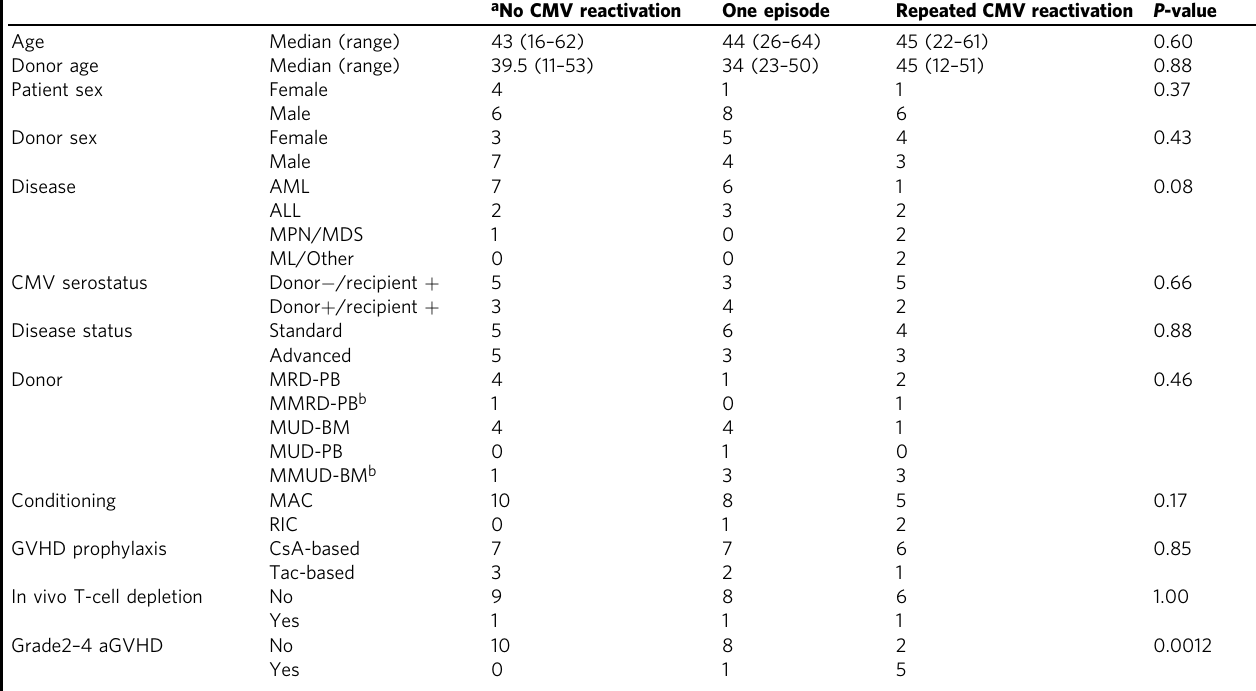
Table 1 Patient